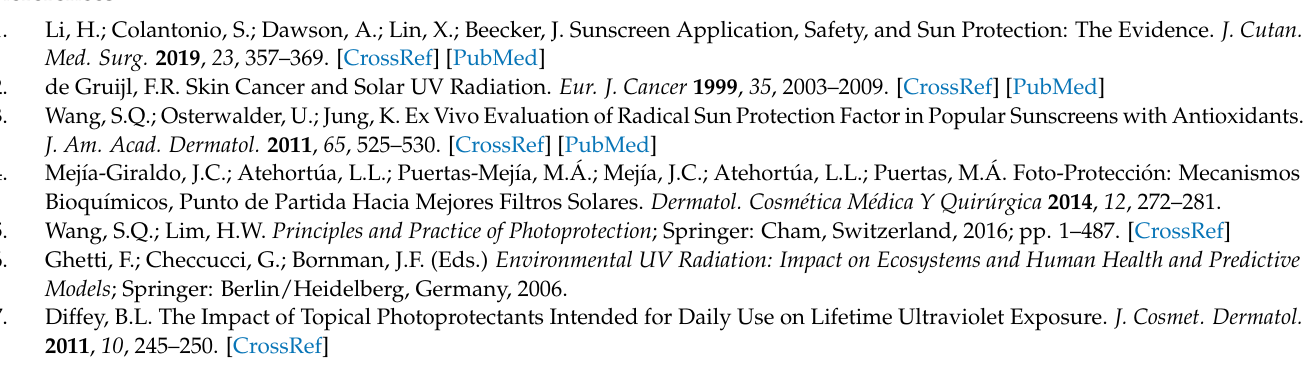
Quercetin; Figure S8. ESI-MS/MS chromatogram for DME; Table S1. Spectral characteristics of the compounds identified in DME; Figure S9. ESI-MS/MS chromatogram for PME; Figure S10. Cell viability of HaCaT exposed to PME; Table S2. Spectral characteristics of the compounds identified in PME; Table S3. Composition of the sunscreen